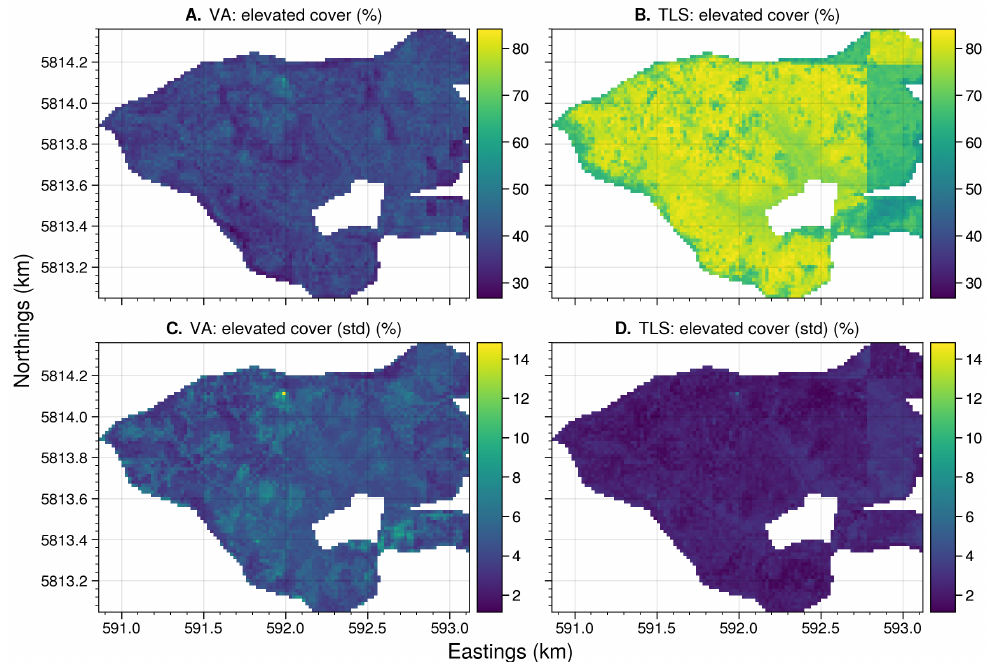
Figure A8. The mean and standard deviation of landscape-level predictions for elevated fuel cover using visual assessments ( A , C ) and TLS ( B , D ) at Toorloo